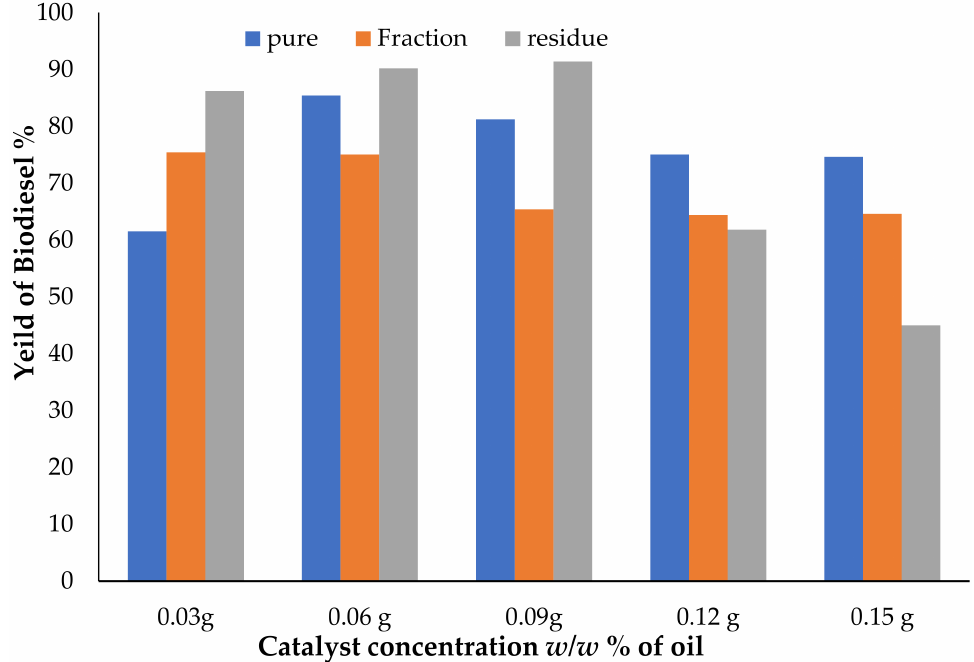
Figure 6. Effect of catalyst concentration on the yield of biodiesel produced from hydrolyzed pure oil, fraction of oil, and